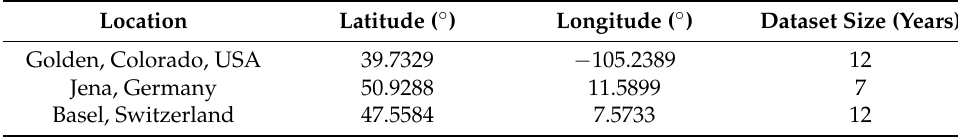
Table 1. The location co-ordinates and dataset size.